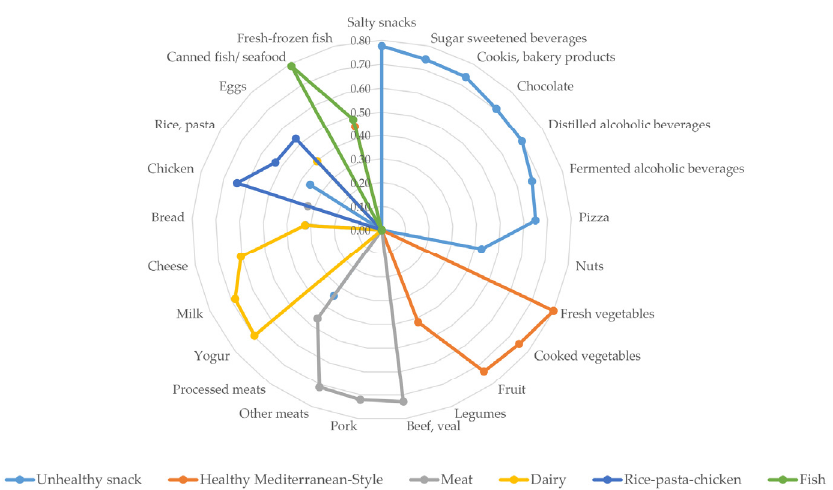
Figure 2. Patterns of change in eating habits during confinement in Spain. Factor scores of patterns identified by factor analysis, principal components. Coefficients <0.30 have been